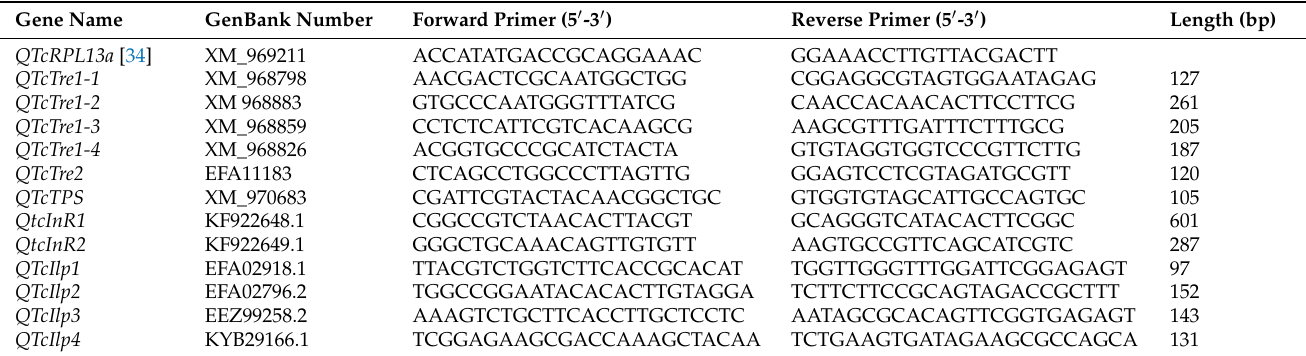
Table 1. Primers used for